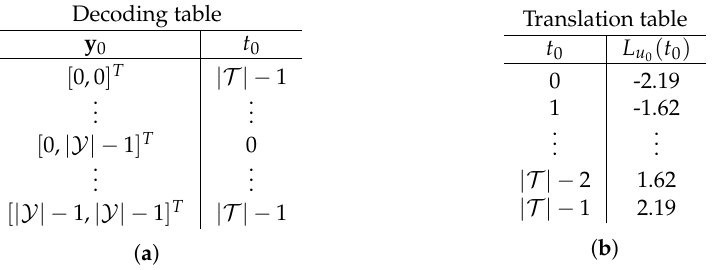
Figure 8. ( a ) Clustering p ( t 0 | y 0 ) that maps the |Y 0 | · |Y 1 | outputs of the bit channel of u 0 to |T | clusters, written as a lookup table. ( b ) Translation table of u 0 obtained from the conditional distribution p ( u 0 | t 0 ) as in Equation